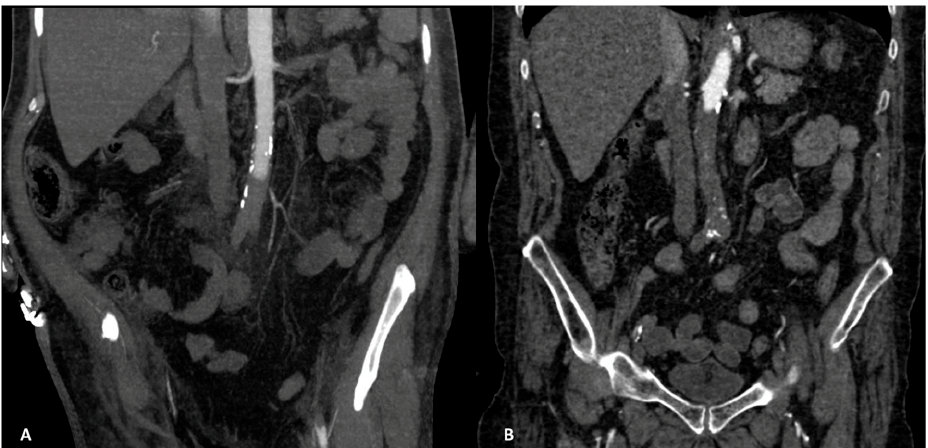
Figure 1. CT angiography, axial planes, arterial phase. The mesenteric inferior artery and its branches are normally enhanced while the aorta is completely occluded, in absence of signs of an- eurysms and dissection.